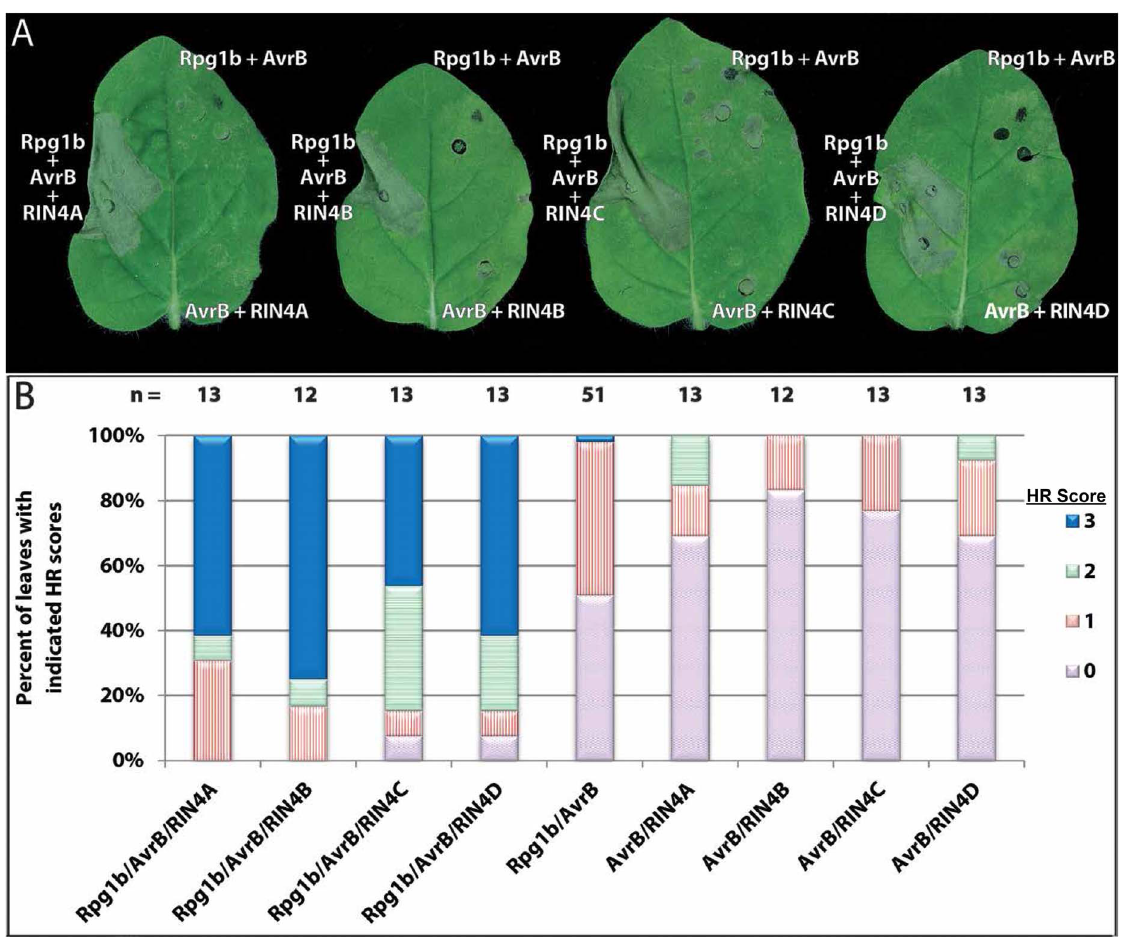
Figure 2. Reconstituting the Rpg1b -mediated defense pathway in N.glutinosa . ( A ) Activation of Rpg1b by AvrB requires co-expression of a GmRIN4 gene. The images shown are of typical responses displayed by N. glutinosa leaves expressing the combination of genes labeled on each image. ( B ) Quantification of Rpg1b -mediated HR when co-expressed with various combinations of AvrB and GmRIN4 genes. The strength of Rpg1b- mediated HR was determined by the extent of leaf collapse in the infiltrated area. Based on the extent of leaf collapse in the infiltrated area, plant leaves were categorized into 4 classes: 0 (no collapse); 1 (less than one third collapsed); 2 (one third to two thirds collapsed); 3 (greater than two thirds collapsed). Images were taken and plant leaves were scored approximately 2 days after transgene induction. The number of leaves infiltrated and scored for each combination (n) is listed above each bar. This experiment was repeated 3 times with similar results.